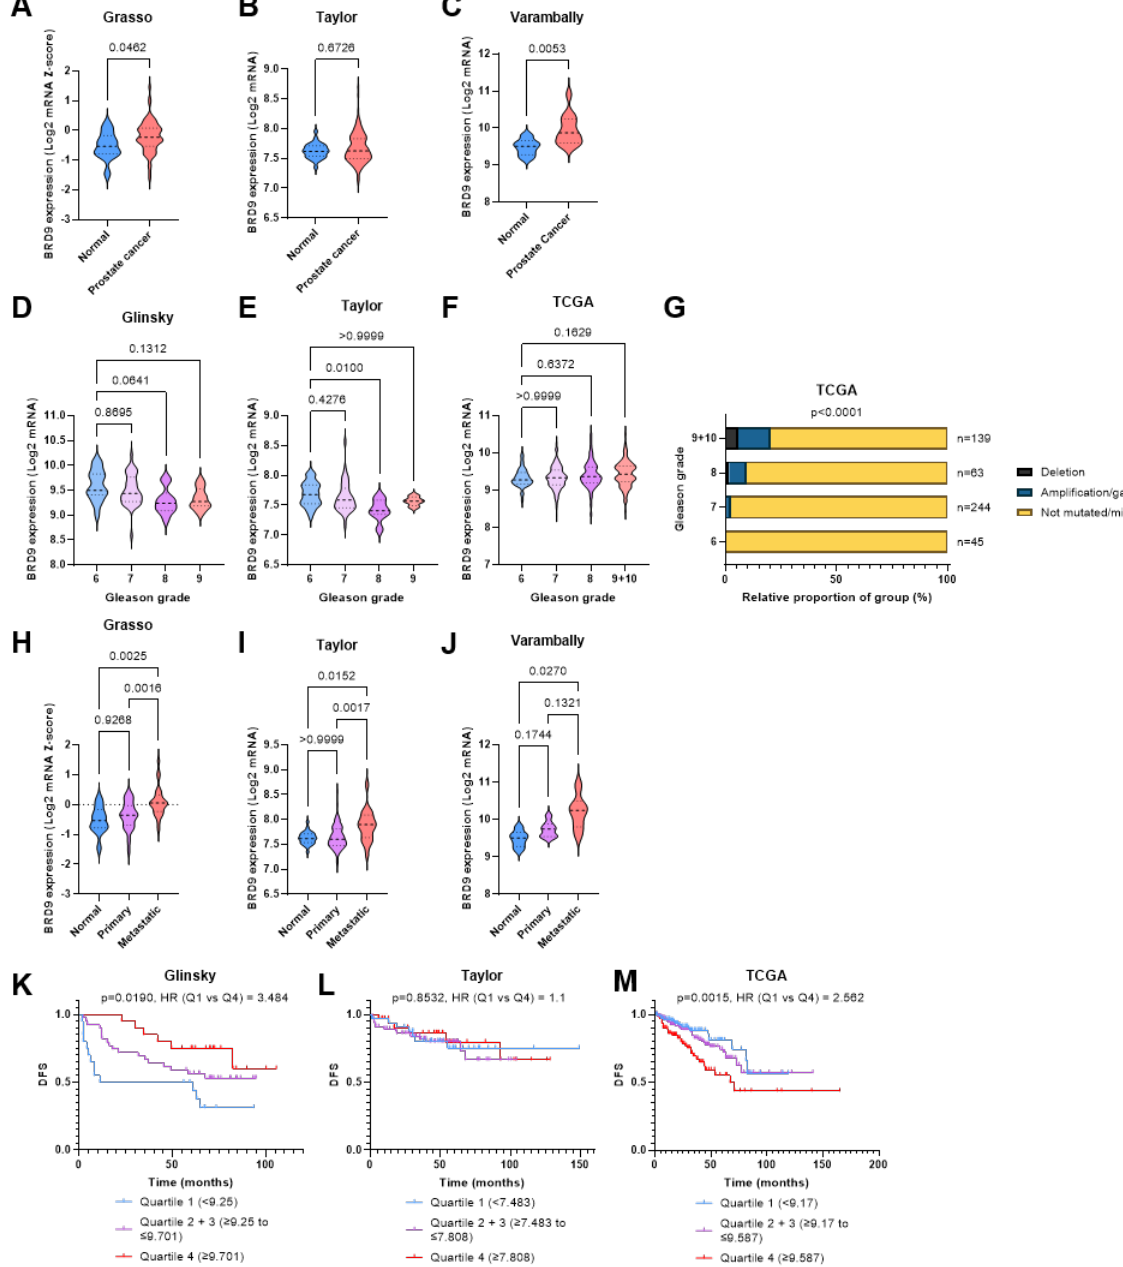
Figure 1. BRD9 as a diagnostic and prognostic biomarker in cancer omics cohorts. ( A ) Violin plot showing BRD9 expression in normal and PCa patients in the Grasso cohort. p -value was obtained using Welch’s t -test. ( B ) Violin plot showing BRD9 expression in normal and PCa patients in the Taylor cohort. p -value was obtained using Mann-Whitney U test. ( C ) Violin plot showing BRD9 expression in normal and PCa patients in the Varambally cohort. p -value was obtained using Welch’s t -test. ( D ) Violin plot showing how BRD9 expression varies with Gleason grade in the Glinsky cohort. p -values were obtained using Dunnett’s T3 post-hoc test. ( E ) Violin plot showing how BRD9 expression varies with Gleason grade in the Taylor cohort. p -values were obtained using Dunn’s post-hoc test. ( F ) Violin plot showing how BRD9 expression varies with Gleason grade in the TCGA cohort. p - values were obtained using Dunnett’s T3 post -hoc test. ( G ) Stacked bar chart showing BRD9 mutation distribution at different Gleason grades and the number of patients at each grade in the TCGA cohort. p - value was obtained via Fisher’s exact test using the Monte Carlo simulation. Grades 9 and 10 have been combined due to an n = 4 sample size at grade 10. ( H ) Violin plot showing how BRD9 expression varies with cancer progression in the Grasso cohort. p - values were obtained using Dunn’s post -hoc test. ( I ) Violin plot showing how BRD9 expression varies with cancer progression in the Taylor cohort. p - values were obtained using Dunn’s post -hoc test. ( J )